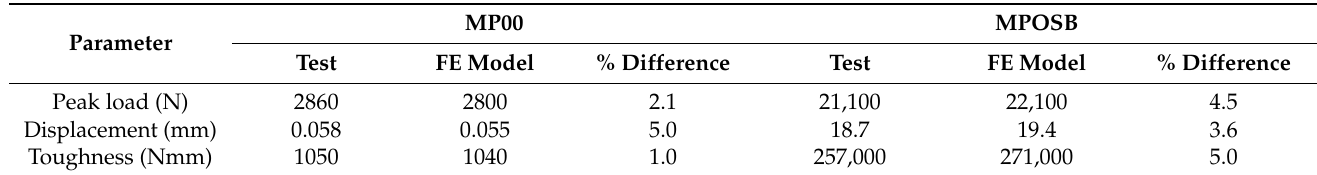
Table 6. Comparison of model and test average results (MP).